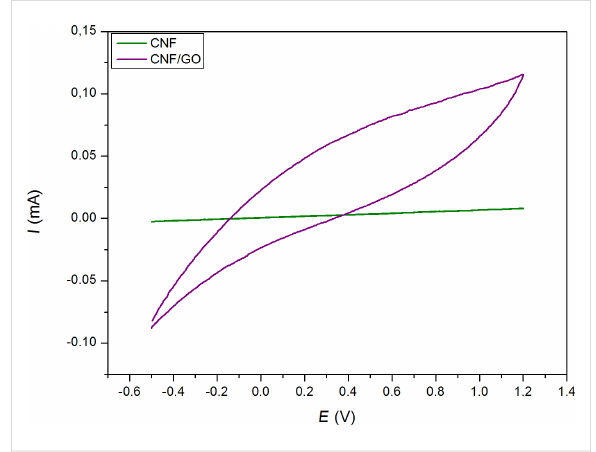
Figure 15: Cyclic voltammograms of carbon nanofibers and GO-con- taining carbon nanofiber webs at scan rate of 50 mV·s − 1 (PAN-based nanofibers with and without GO, first oxidized then